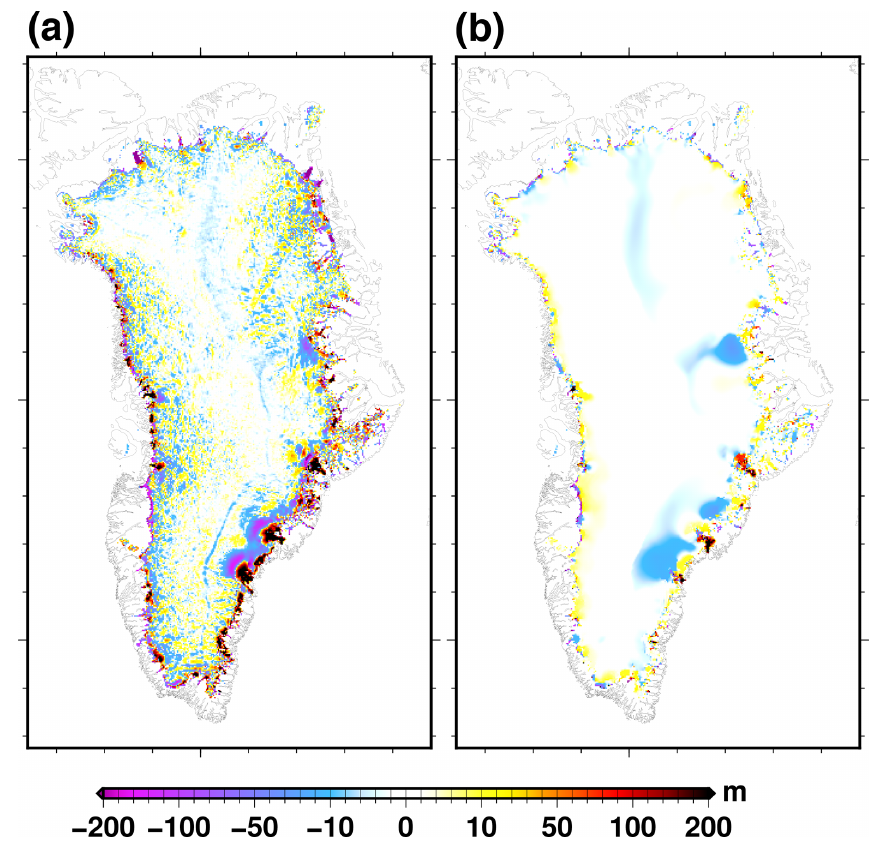
Figure 2. Ice thickness difference: (a) end of the historical experiment hist (2015) with respect to the observations (Morlighem et al., 2017); (b) end of the control experiment ctrl_proj (2100) with respect to the end of historical experiment hist (2015).